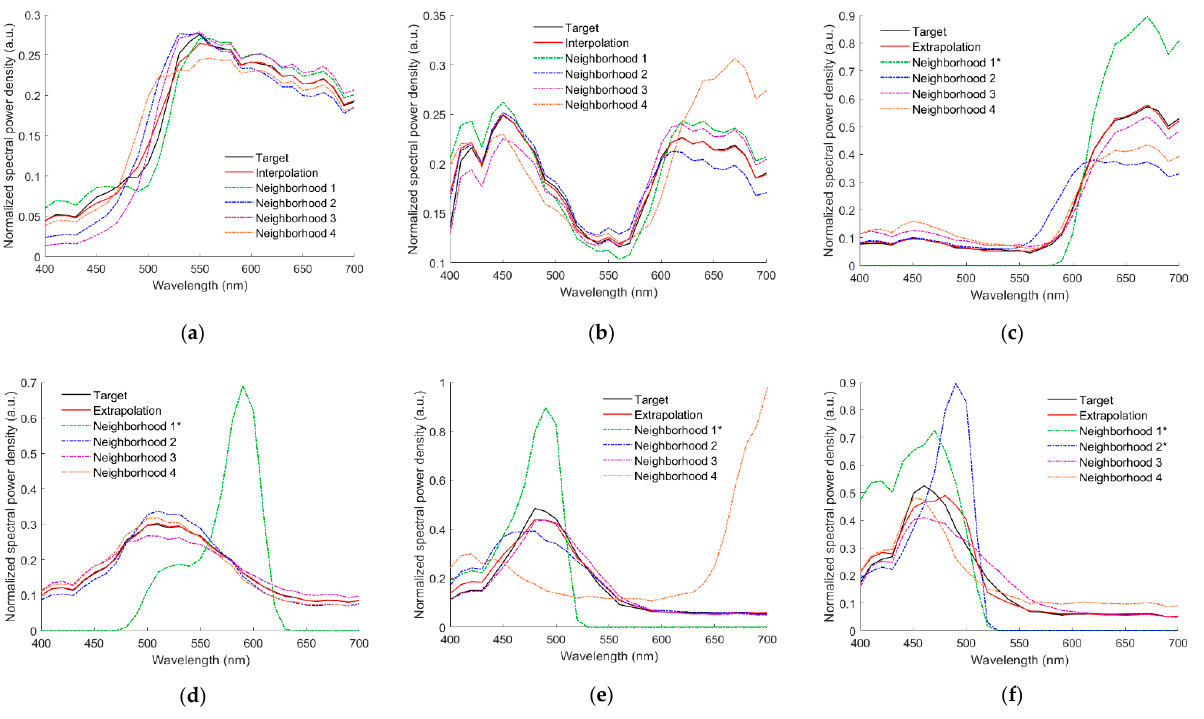
Figure 10. Normalized target spectrum N Reflection , reconstructed spectra N Rec , and neighboring reference spectra using the RGBF camera and II-LUT method. Munsell annotations of the color chips are ( a ) 5Y 8.5/8, ( b ) 10P 7/8, ( c ) 2.5R 4/12, ( d ) 2.5G 7/6, ( e ) 10BG 4/8, and ( f ) 5PB 4/12, respectively. Normalized ARS neighborhood is indicated with “*” in the legend.